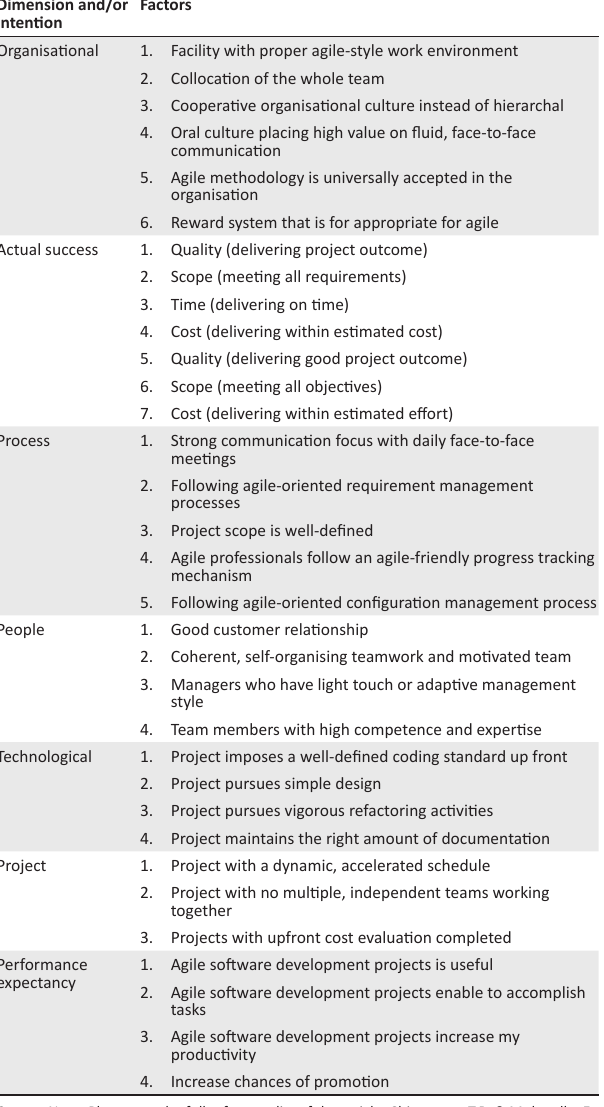
TABLE 1: Success factors of the agile projects Dimension and/or